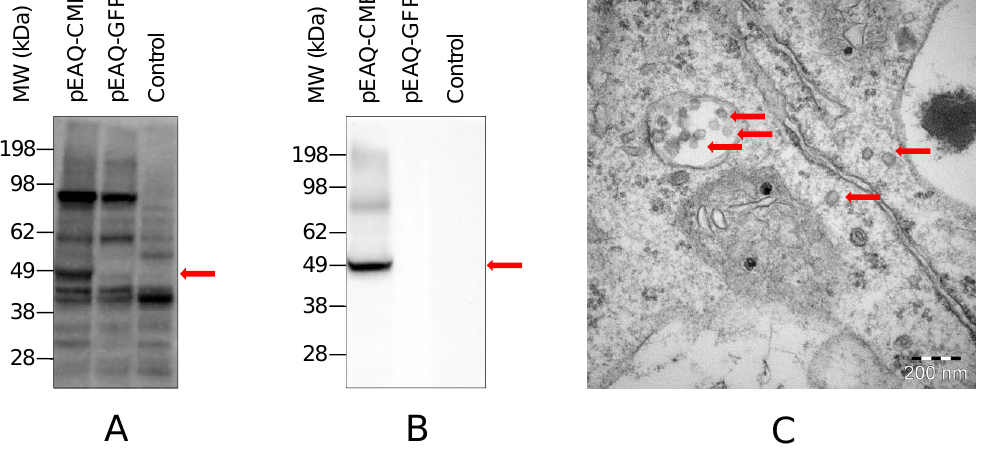
Figure 2. Expression and assembly of TBEV structural proteins producing virus like particles (VLP) in N. benthamiana . Plant leaves infiltrated with the transformed A. tumefaciens (OD 600 0.8–1.0) were an- alyzed 7 days post infiltration. Protein E expression by pEAQ-CME in N. benthamiana was visualized by Western blotting using polyclonal ( A ) and monoclonal ( B ) antibodies against the E protein (red arrow). Protein extracts from pEAQ-GFP and non-infiltrated (control) leaves were used as negative controls ( A , B ). Particles similar to TBEV VLPs, ~50 nm in diameter, (red arrows) localized in the endosome and other parts as visualized by transmission electron microscopy ( C